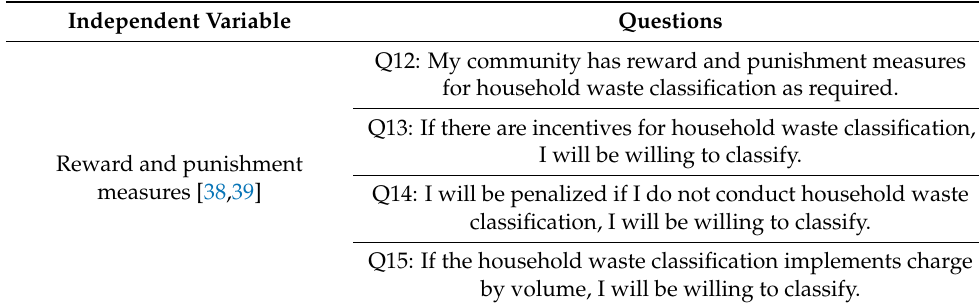
Table 3. Reward and punishment